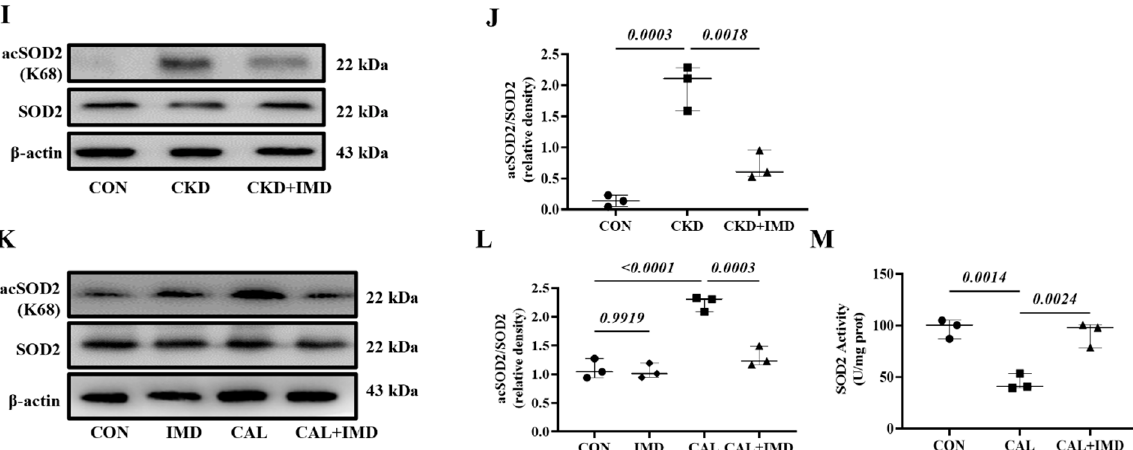
Figure 2. IMD inhibited mitochondrial oxidative stress in calcified VSMCs. ( A ) JC-1 probing mito- chondrial membrane potential in rat VSMCs (red: JC-1 aggregates, green: JC-1 monomers). Merged images are shown (Scale bar = 50 μ m). ( B ) Ratio of average fluorescence intensity of JC-1 aggregates to JC-1 monomers ( n = 3). ( C ) MitoSOX Red probing mitochondrial ROS in rat VSMCs (positive staining: red). Nuclei were stained with DAPI (blue). Merged images are shown (Scale bar = 50 μ m). ( D ) Average fluorescence intensity of MitoSOX in rat VSMCs ( n = 3). ( E ) DHE probing ROS in rat VSMCs (positive staining: red). Nuclei were stained with DAPI (blue). Merged images are shown (Scale bar = 50 μ m). ( F ) Average fluorescence intensity of DHE in rat VSMCs ( n = 3). ( G ) DHE probing ROS in rat aortas (positive staining: red). Nuclei were stained with DAPI (blue). Merged images are shown (Scale bar = 200 μ m). ( H ) Average fluorescence intensity of DHE in rat aortas ( n = 3). Western blot analysis of protein levels of acetylation-SOD2 (K68) and SOD2 in ( I ) rat aortas and ( K ) rat VSMCs, and ( J , L ) quantification of acetylation-SOD2 to SOD2 ratio ( n = 3). ( M ) SOD2 activity in rat VSMCs ( n = 3). CON (circles): control rats or VSMCs, CKD (squares in (H) and (J)): CKD vascular calcification rats, CKD + IMD (triangles in (H) and (J)): CKD vascular calcification rats with IMD 1-53 treatment, IMD (diamonds in (L)): control VSMCs with IMD 1-53 treatment, CAL (squares in (B,D,E,L,M)): calcification VSMCs, CAL + IMD (triangles in (B,D,E,L,M)): calcification VSMCs with IMD 1-53 treatment. Data are mean ± SD.